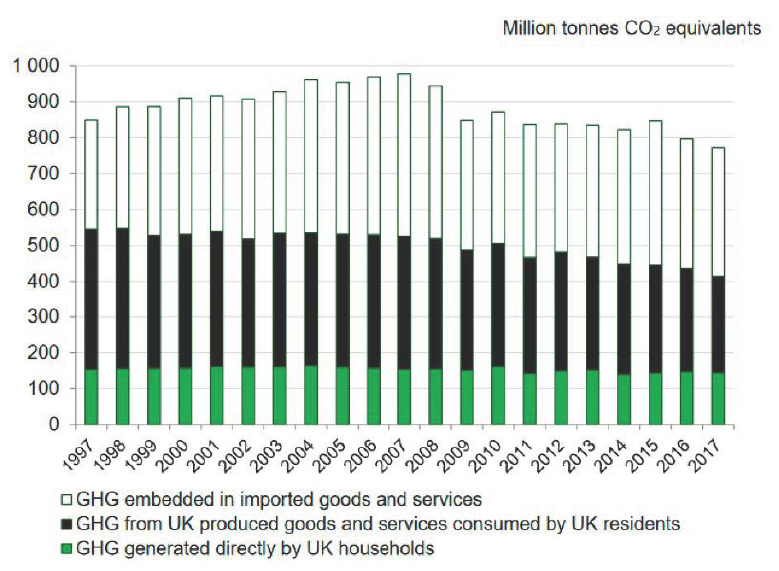
Figure 1. UK greenhouse gas (GHG) emissions related to consumption from 1997–2017 [6].